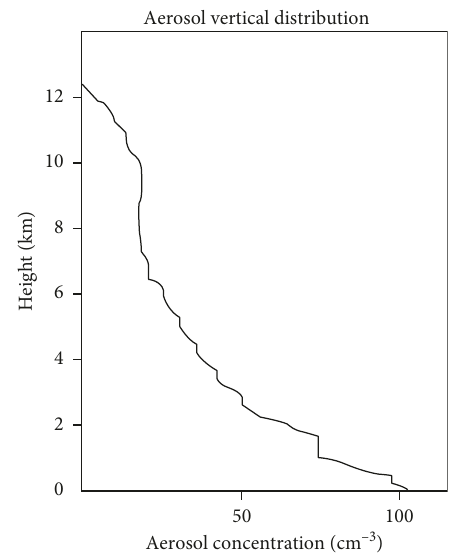
Figure 3: Initial vertical distribution of total aerosol concentration in the accumulation mode.